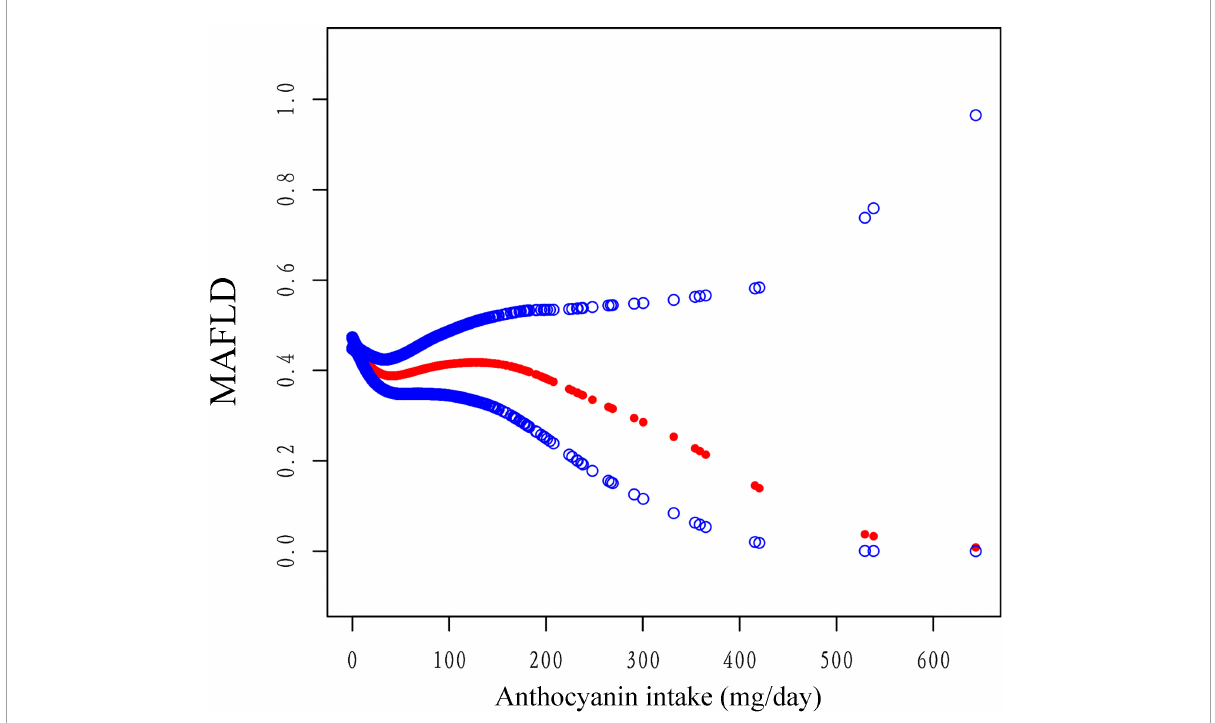
FIGURE2 The association between anthocyanidin intake and the risk of MAFLD using smooth curve fitting, weighted. The covariates of age, sex, race, PIR, smoking status, alcohol drinking status, education level, total energy and HEI-2015 scores were adjusted. The red points line represented the fitting spline. The blue points line represented the 95% confidence